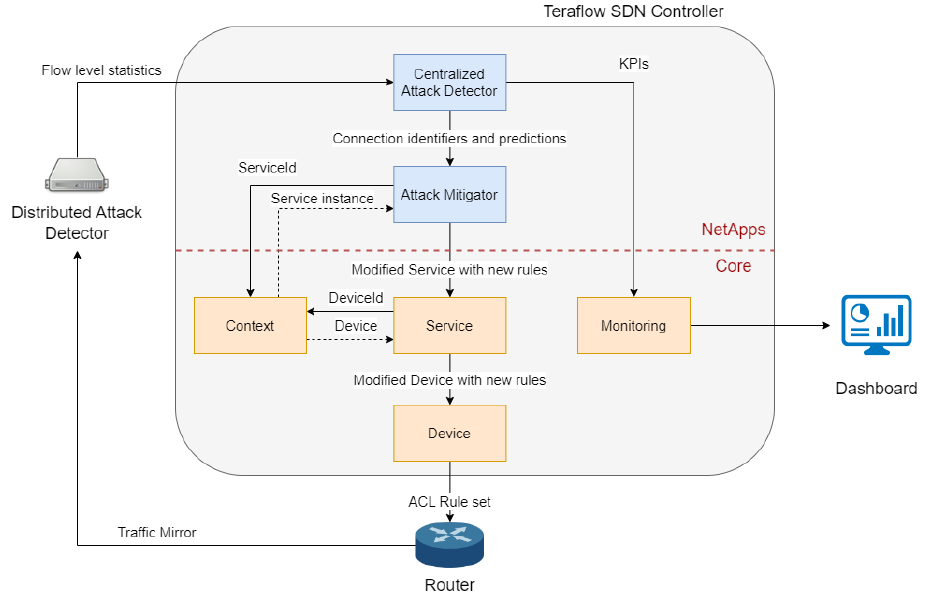
Figure 3. Cybersecurity component